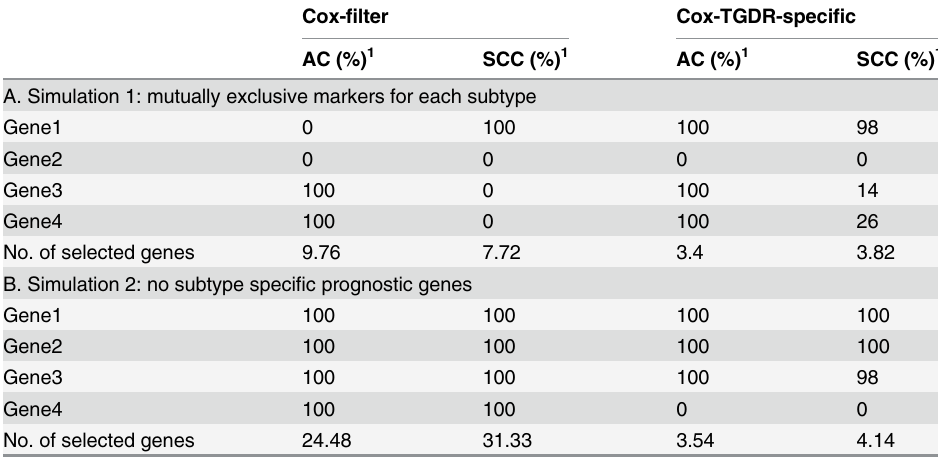
Table 2. Performance of Cox-TGDR-specific and Cox-filter on simulated